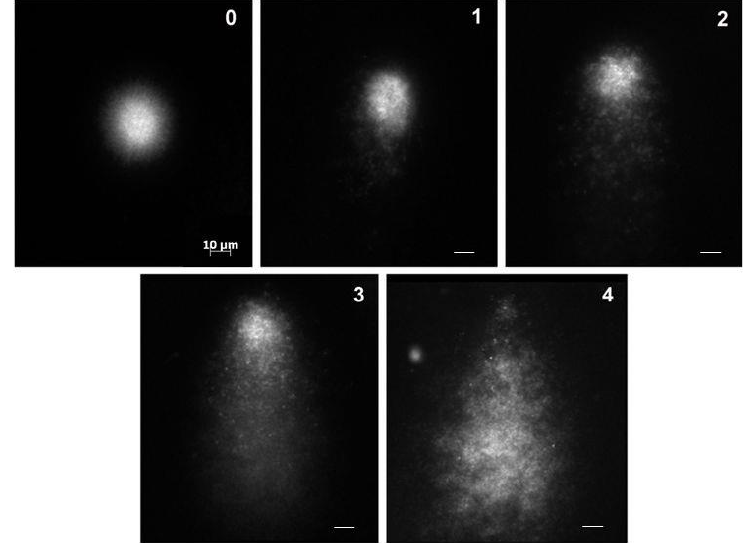
Figure 5. Grading of the DNA damage in human leukocytes: ( 0 ) no damage; ( 1 ) low level of DNA damage; ( 2 ) medium level of DNA damage; ( 3 ) high level of DNA damage; and ( 4 ) maximum level of DNA damage. Bar in the first picture (0) = 10 μm, and is also valid for all micrographs.